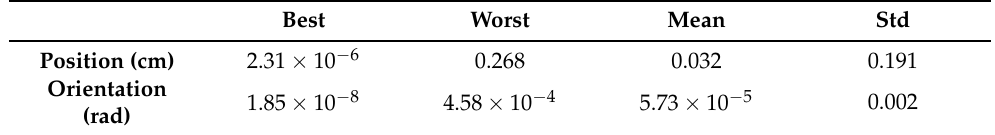
Table 4. Statistical errors analysis of MO-M-PSO for circular path